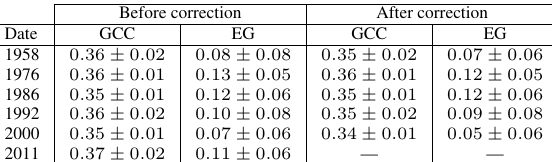
Figure 5. Colorization results for the corrected archive aerial photographs.